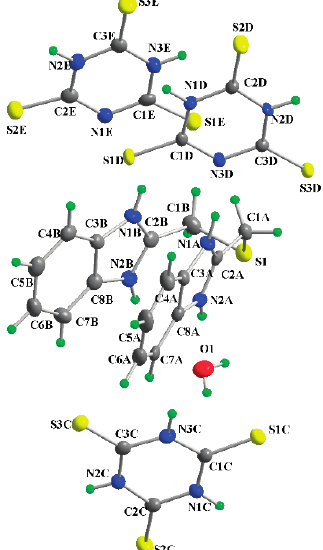
Figure 4. Numbering scheme of 2 with atomic displacement ellipsoids drawn at 30% probability